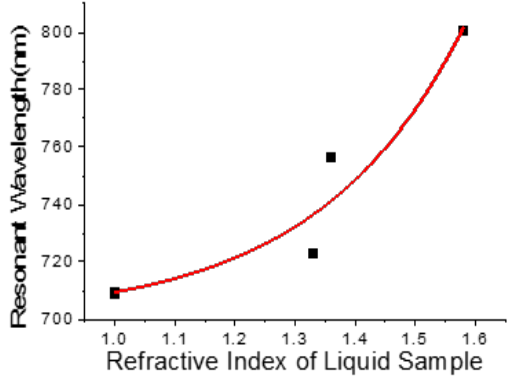
Figure 8. Fitting result of fiber SPR sensor in refractive index measurement